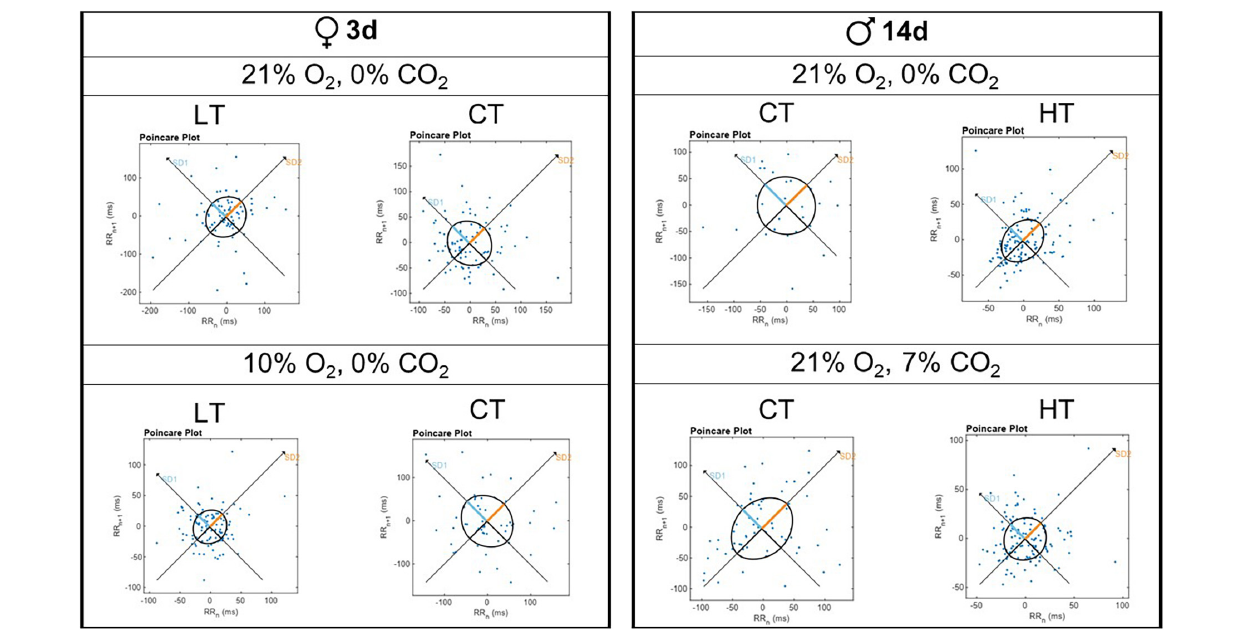
FIGURE 5 | Representative Poincaré plot graphs for breathing variability during normoxia/normocapnia (21% O 2 /0% CO 2 ), hypercapnia (7% CO 2 ) and hypoxia (10% O 2 ) of a 3d female and a 14d